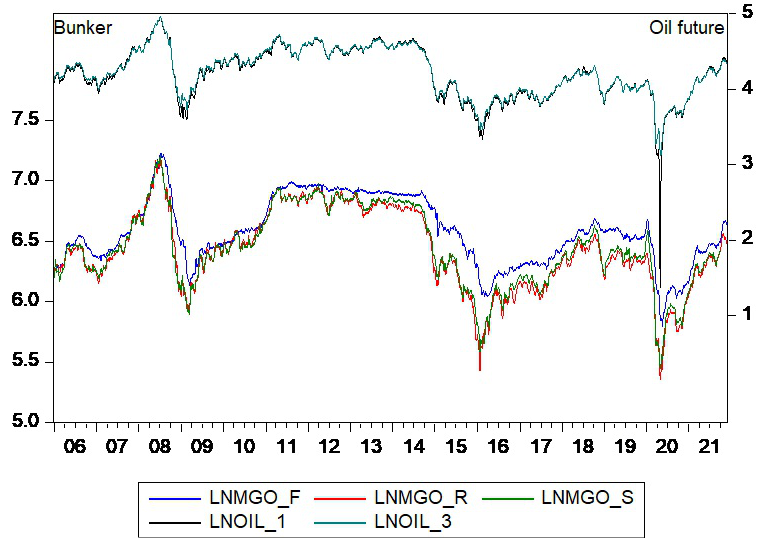
Figure 1. The trend of MGO and oil future prices (Data source: Shipping Intelligence Network and U.S. Energy Information Administration). Table 1. Some key summary statistics (30 December 2005–24 September 2021).